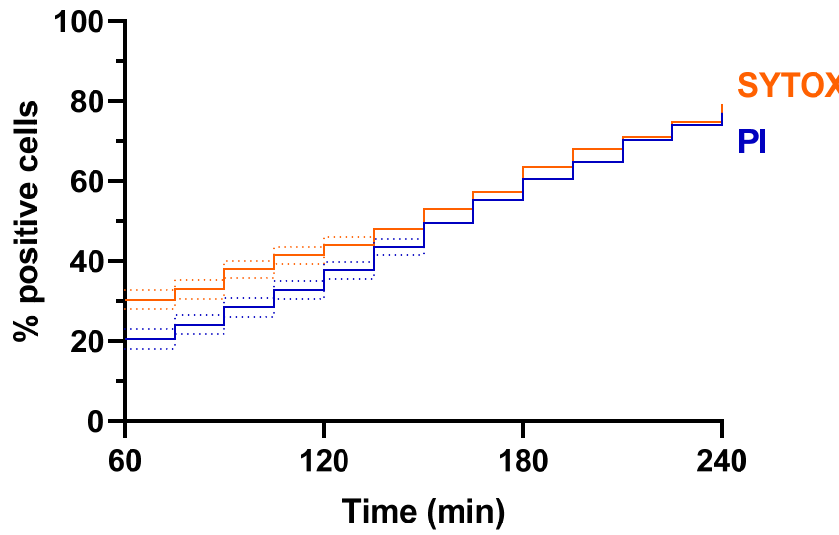
Figure 3. Comparing the percentages of fluorescently positive single yeast cells upon treatment with HsAFP1 evaluated by PI or SYTOX. Yeast cells were treated with 100 µ g/mL HsAFP1 during 3 h on-chip, resulting in 4 h of total treatment at room temperature using PI (blue) or SYTOX (orange) for evaluating membrane permeabilization. Images were taken every 15 min. A minimum of 1008 cells was evaluated for every condition. Significant differences were determined using a likelihood ratio test on the Cox proportional hazards regression for survival data ( α = 0.05). Dotted lines represent asymmetrical 95% confidence intervals. No significant differences could be observed.